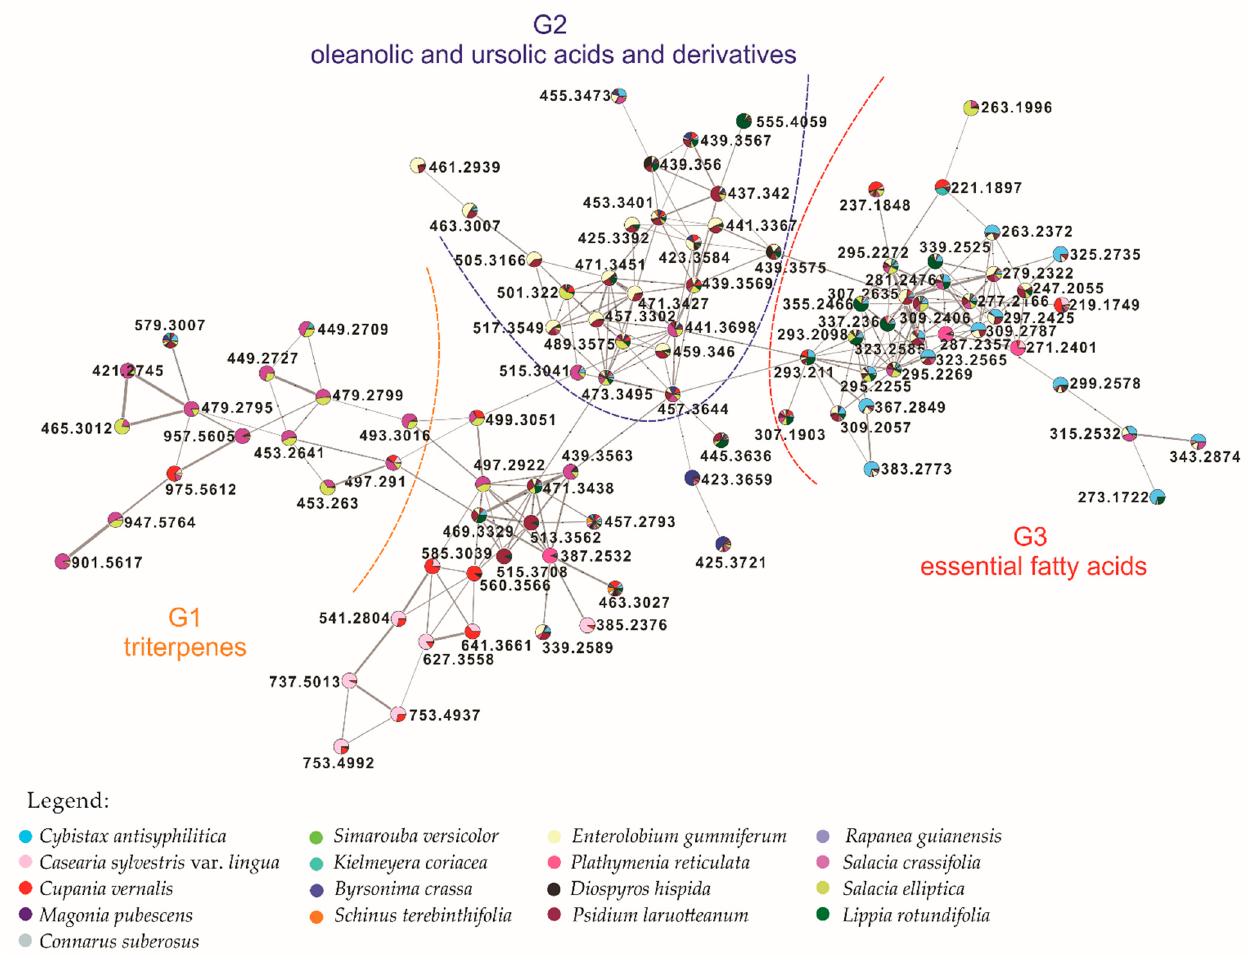
Figure 3. Main cluster-3 sub-networks: G1 triterpenes; G2 oleanolic and ursolic acids and derivatives; G3 essential fatty acids–linoleic and linolenic acids and derivatives.